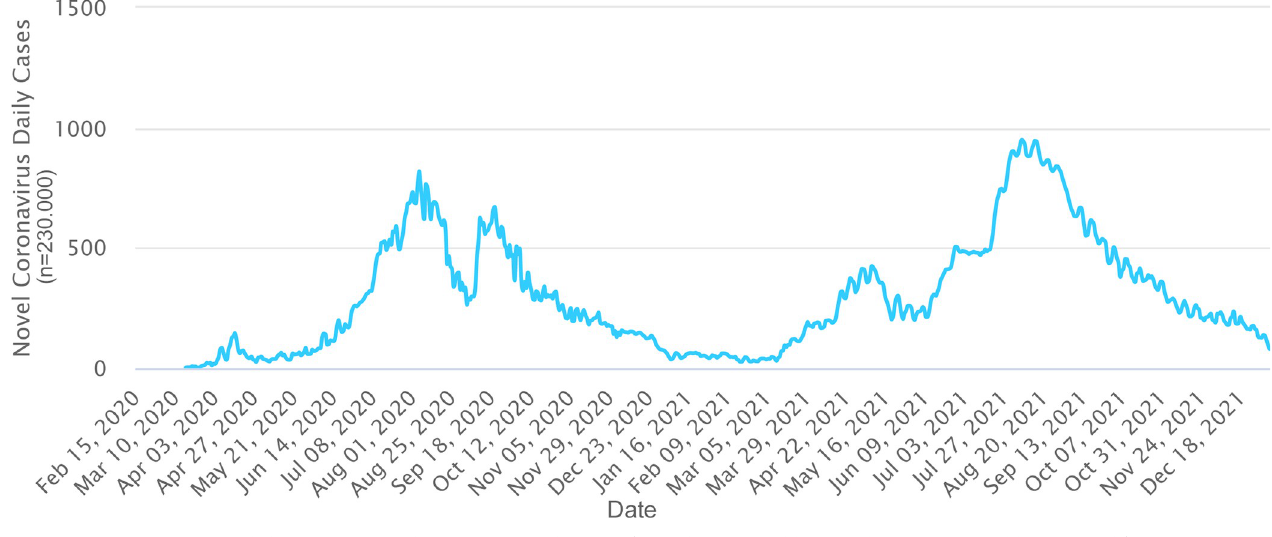
Fig 1. COVID-19 cases in Uzbekistan since March 2020 to September 2021 (according to Worldometer, https://www.worldometers.info).